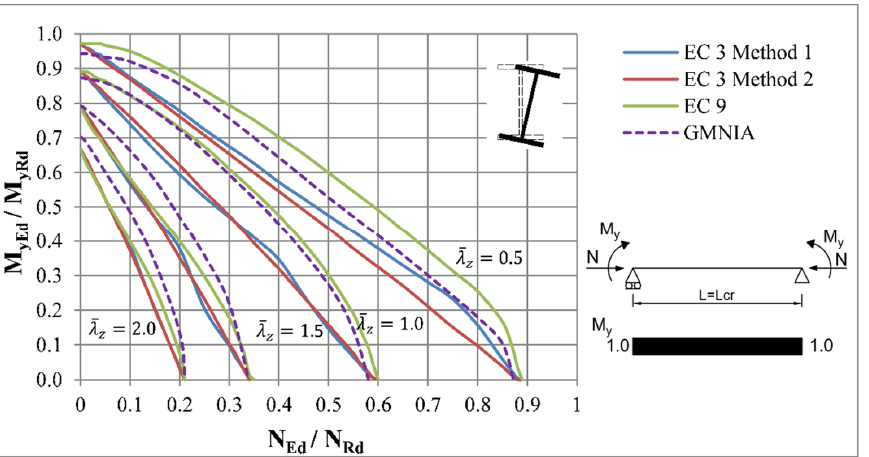
Figure 15. Interaction curves for laterally unrestrained beam-columns with IPE 100 cross-section with restrained warping.